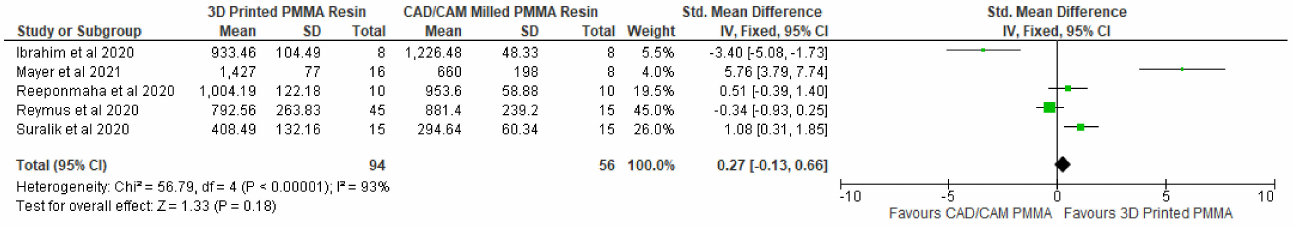
Figure 5. Forest plot comparing fracture strength between 3D-printed PMMA resin and CAD/CAM milled PMMA resin.